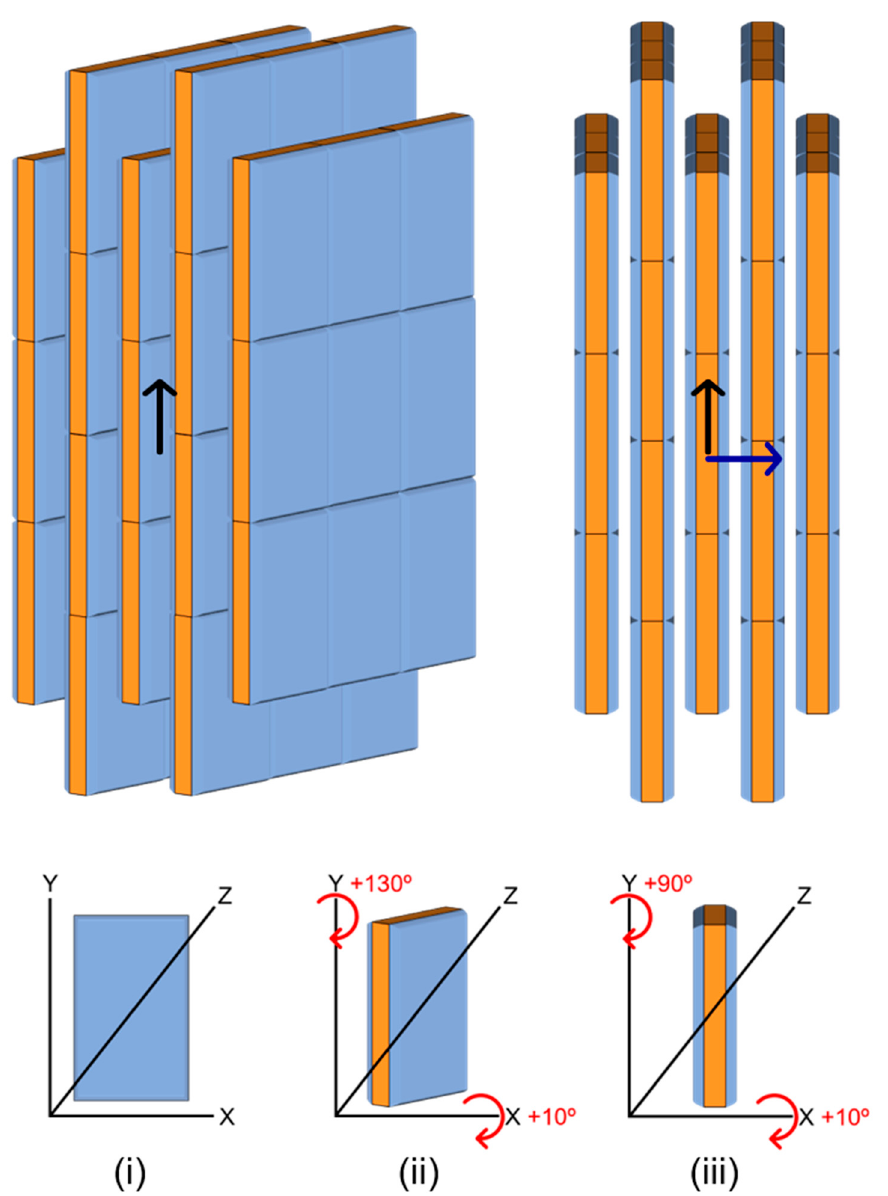
Figure 7. A simplified schematic drawing of the local organization of bone mineral platelets in vivo. Here is schematized the presumed local organization of mature bone mineral nanoparticles throughout the bone extracellular matrix in vivo. It was deducted according to the self-organized structures that bone-like platelet-shaped hydroxyapatite particles form spontaneously in water. This organization is here depicted in a simplified manner in which the mineral platelets have similar shapes and dimensions, together with an identical orientation. A model with a staggered arrangement of mineral platelets was considered according to the work of Ingomar Jäger and Peter Fratzl [61]. The largest side faces of the platelets are filled in blue (a single platelet is shown face-on in ( i )), while their smallest side faces together with their basal faces are filled in orange (a single platelet is shown tilted and edge-on in ( ii , iii ), respectively). The platelets are not only aligned with each other but are also arranged side-by-side, respectively parallel (black arrow) and perpendicular (blue arrow) to their elongated direction. The largest side faces of the platelets are, therefore, facing each other but are separated by water-filled gaps, and the platelets are also interlocked together via a tight pairing of their basal faces. The assumption was made here that the platelets also assemble at the level of their smallest side faces to form “a mosaic composed of interlocking crystal tiles” [22]; however, our two-dimensional imaging data could not confirm this.